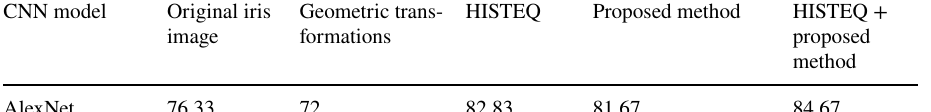
proposed method